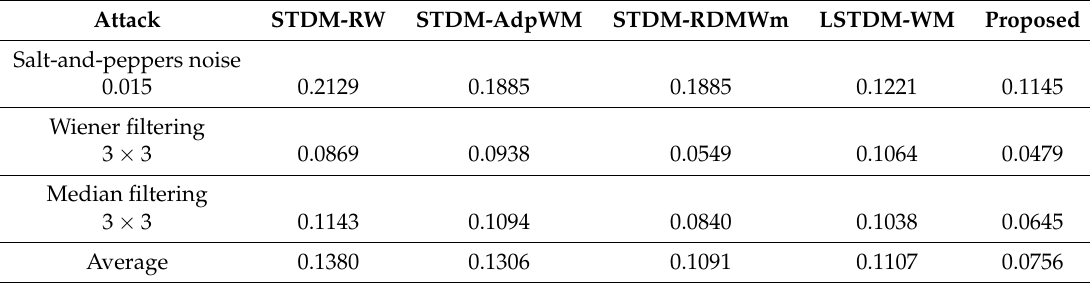
Figure 8. BER versus volumetric scaling factor for different watermarking algorithms with VSI = 0.982. From the robustness results with volumetric scaling in Figure 8, the watermarking scheme based on visual saliency JND model performs better than others. The proposed method has good robustness for volumetric scaling attack. Table 2. The BER comparisons for some common attacks with VSI =